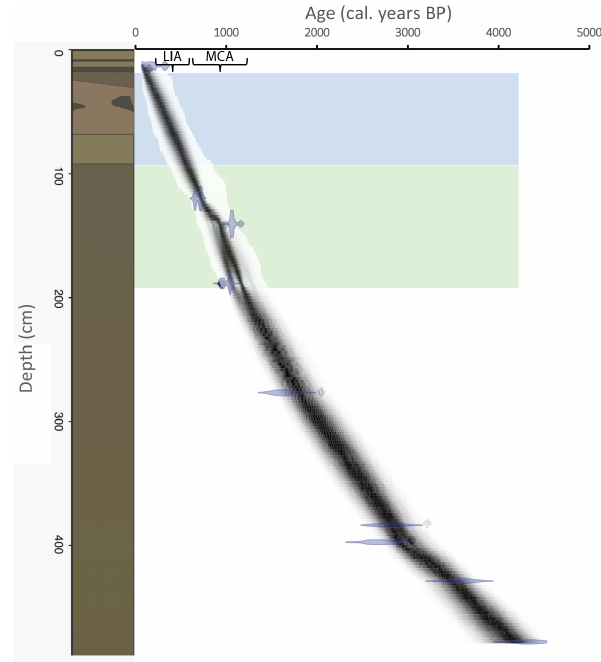
Figure 3. Left: core log of GeoB18308-1 (internal structures with recorded colors) demonstrating the presence of an event deposit (blue box). Right: the calibrated 14 C dates (transparent blue) and the age–depth model (darker greys indicate more likely calendar ages; grey stippled lines show 95% confidence intervals; red curve shows single “best” model based on the weighed mean age for each depth). The green box marks horizons of increased terrestrial input where a terrestrial calibration curve (SHCal13: Southern Hemisphere; Hogg et al., 2013) was used. Otherwise, Marine13-modeled ocean aver- age (Reimer et al., 2013) with a δ R following Dewar et al. (2012). Redeposited material (i.e., a crab claw at 123cm depth, a bivalve at 285cm and the reworked package at 30–60cm depth) were ex- cluded from the age–depth modeling. Medieval Climate Anomaly (MCA) and the Little Ice Age (LIA) are